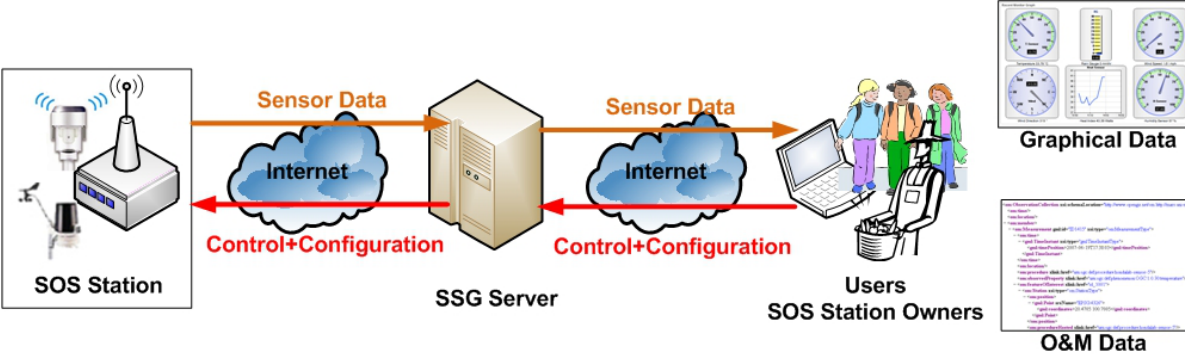
Figure 2. Information Flow from SOS Station to SSG to User.